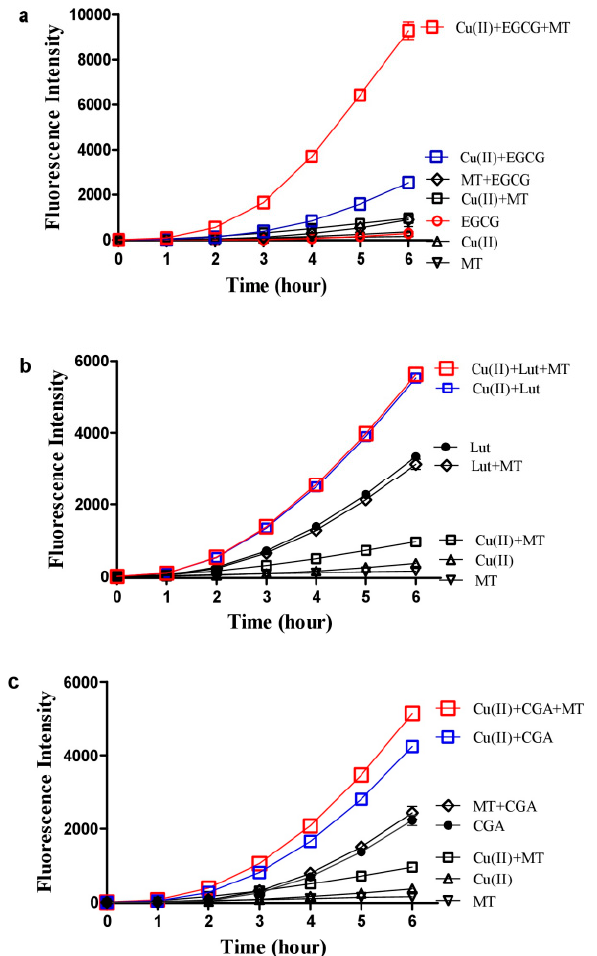
Figure 3. Influence of melatonin on ROS production from copper and other polyphenols. ( a ) EGCG. ( b ) Luteolin (Lut). ( c ) Chlorogenic acid (CGA). In 0.05 M PBS (pH 7.4), the examined polyphenol was 10 μ M, the Cu(II) was 1 μ M and the melatonin (MT) was 100 μ M. The reaction mixtures were incubated at 37 °C. Data are presented as the mean of two replicates; the error bar represents the range. In most data points, the range was smaller than the symbol.